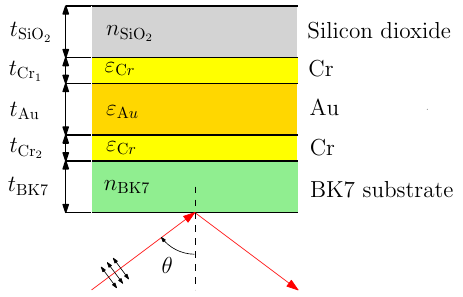
Figure 1. Schematic drawing of a multilayer